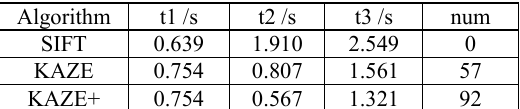
Figure 4. The matching result of IRS-P5 image (434*379) and SPOT5 image(246*225)